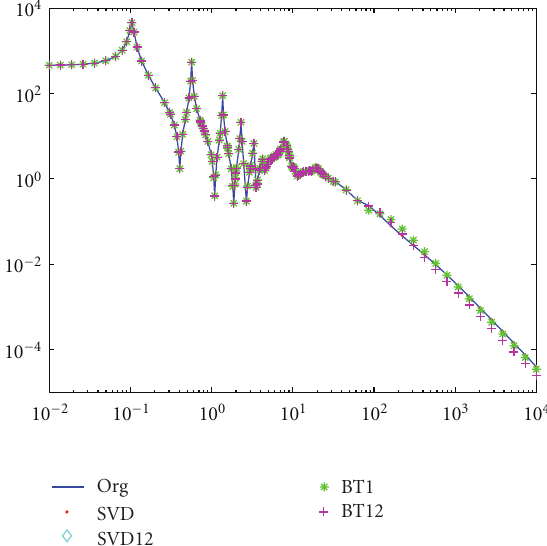
Figure 2: Frequency response on clamped beam model with size n = 174 and the reduced model of size r = 29 by four di ff erent